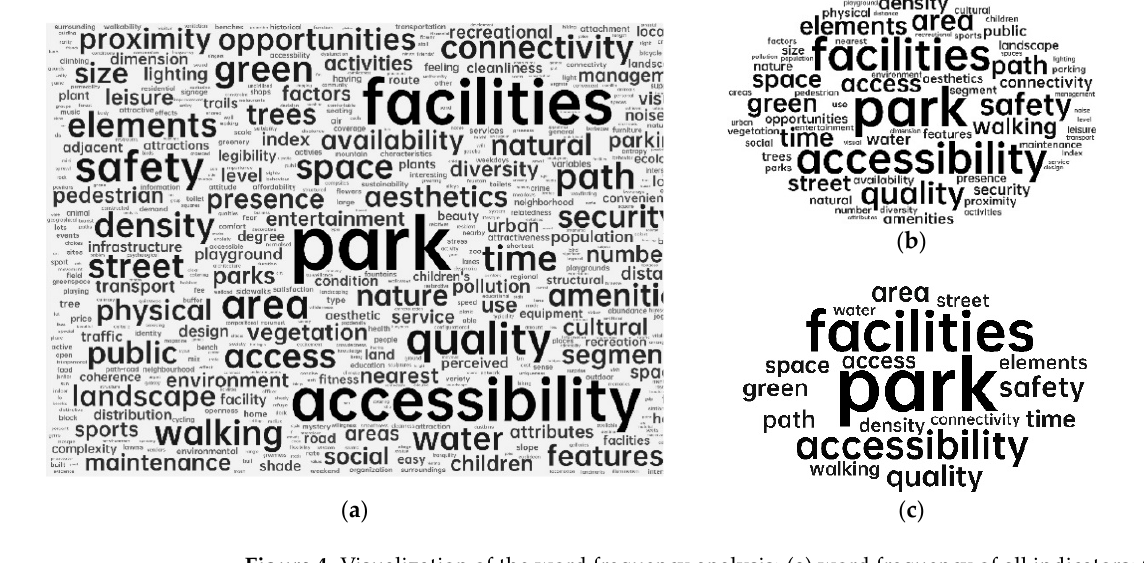
Figure 4. Visualization of the word frequency analysis: ( a ) word frequency of all indicators; ( b ) word frequency of indicators appearing more than 5 times; ( c ) word frequency of indicators appearing more than 10 times.